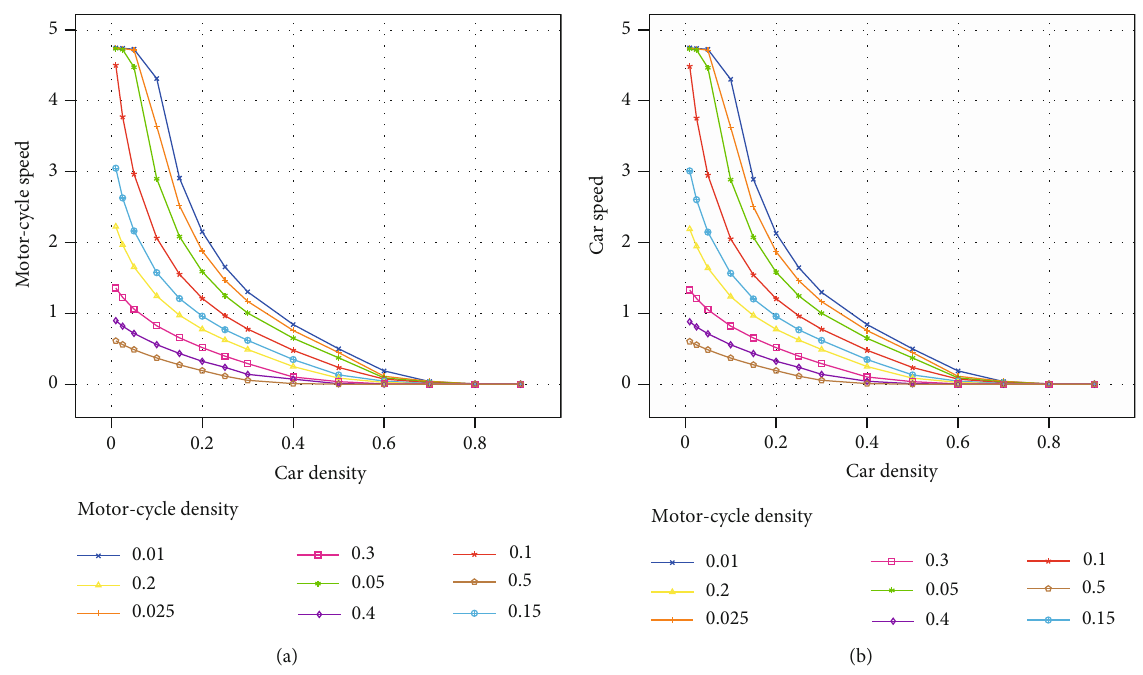
Figure 4: (a) Speed density diagrams with sp = 0 : 25 and Ip = 0 : 25 for di ff erent motorcycle densities. (b) Speed density diagrams for cars with sp = 0 : 25 and Ip = 0 : 25 for di ff erent motorcycle densities.